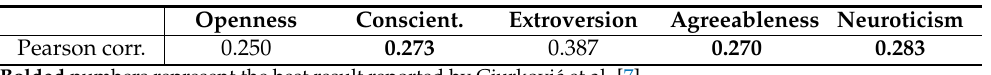
Table 5. The Pearson correlation coefficient between the gold-standard Big Five labels and the predicted values of MBTI types and Big Five traits. Correlations adapted from the work of Gjurkovi´c et al. [7] CC-BY-NC. Openness Conscient. Extroversion Agreeableness Predicted...